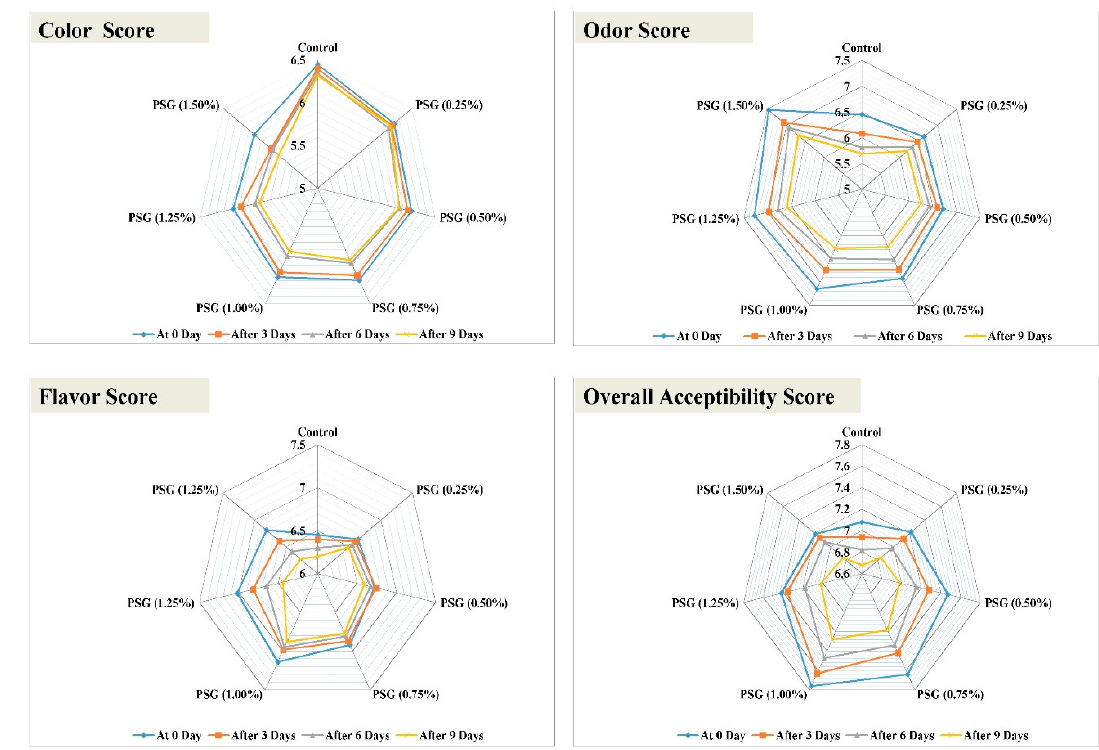
Figure 4. Sensory properties of flaxseed-derived-PSG-supplemented yoghurt at different storage interval.